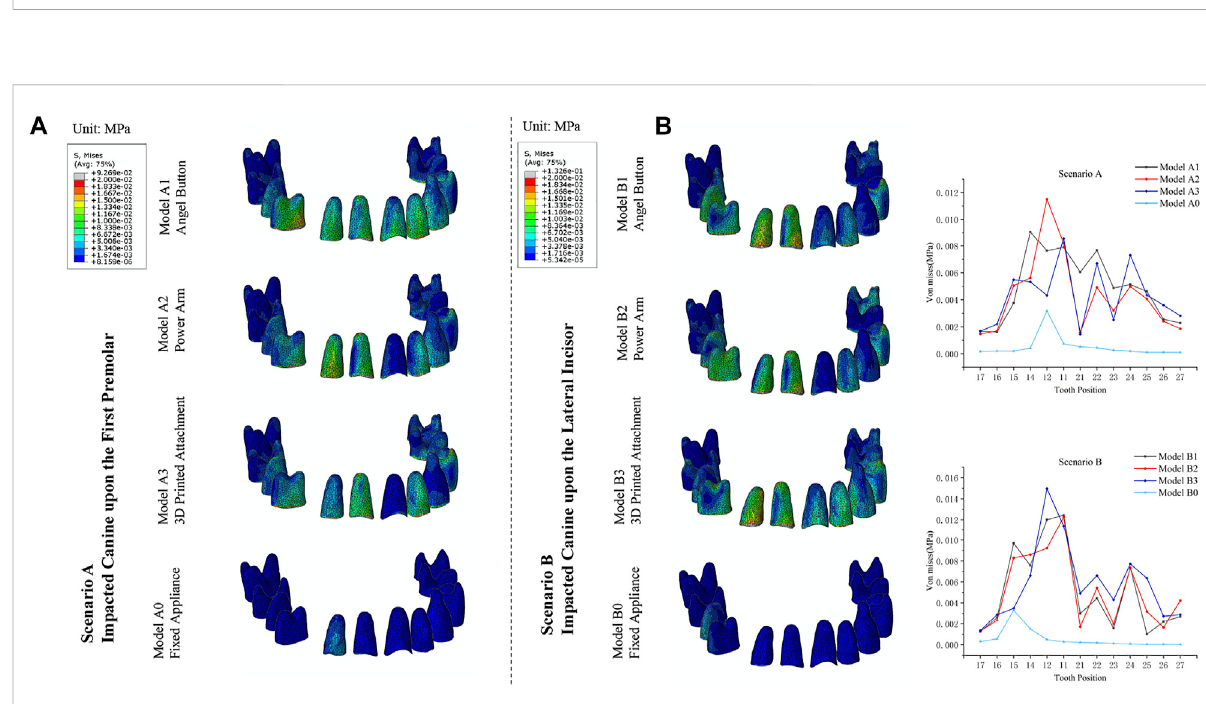
FIGURE 6 (A) The von Mises distribution in the PDL of the anchorage teeth in response to the different traction models used to move a maxillary right labially impacted canine of Scenario A and Scenario B. (B) Stress value for average von Mises in the PDL of the anchorage